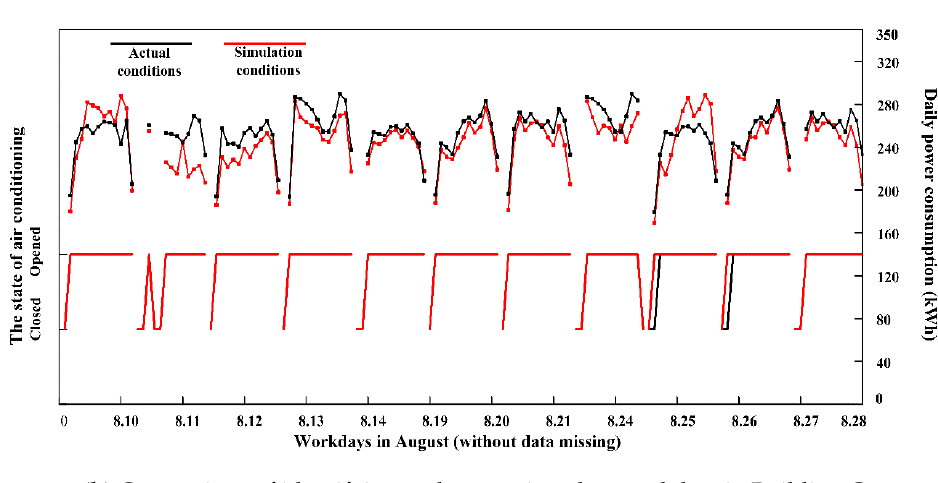
Figure 19. Comparison of identifying and separating abnormal data by the proposed method. The relative errors of separation in Buildings A, B, and C are shown in Figure 20. The relative error of buildings having different functions is within 15%, and the relative error less than 10% in each building is more than 85%, which indicates the high applicability of the proposed method.